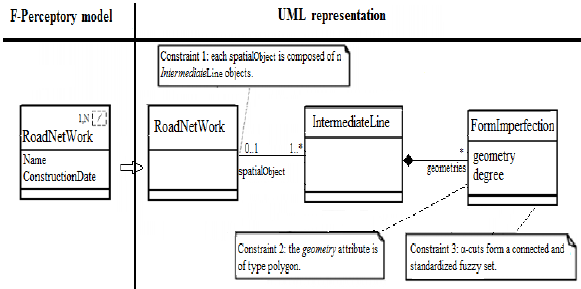
Figure 6. Fuzzy simple aggregate polygon mapping